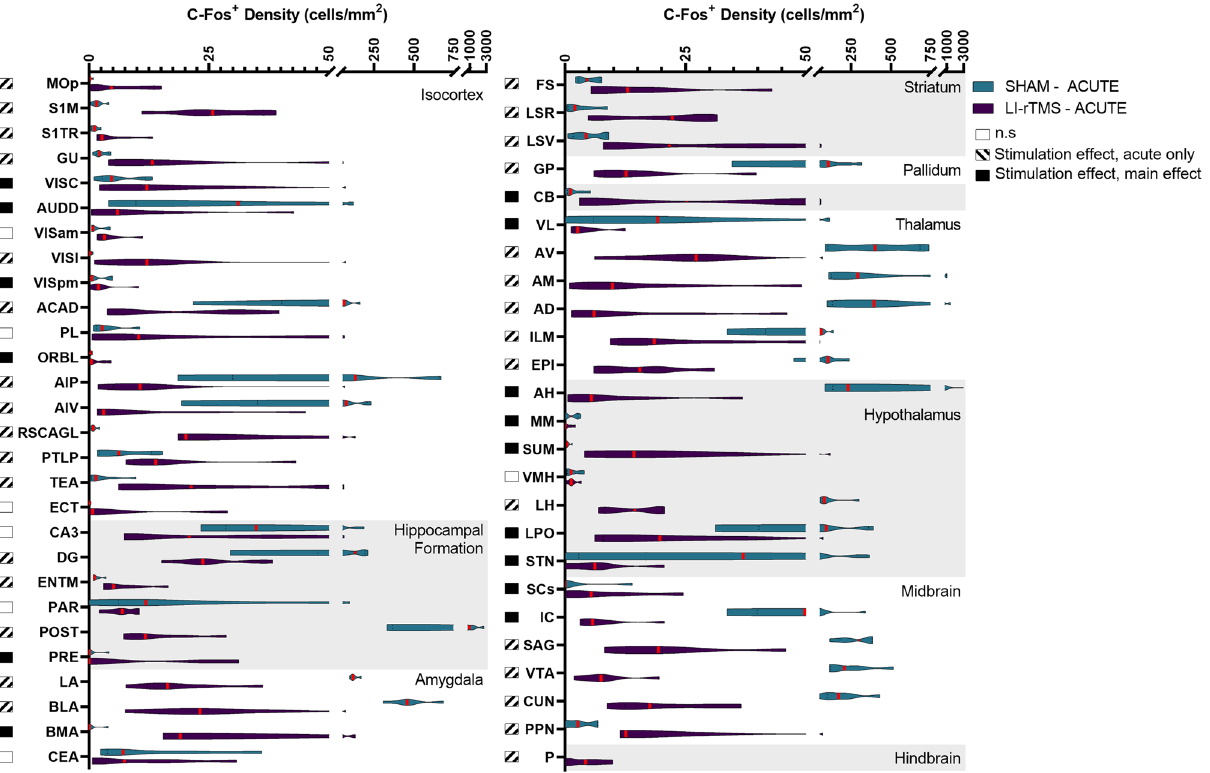
Figure 1. C-Fos cell density in mice in the acute stimulation group for regions which had a significant effect related to stimulation across all groups. Violin graphs represent c-Fos cell density (cells/mm 2 ) for mice that received acute active or sham stimulation organised by hierarchical brain regions. Red lines indicate the median value. Shaded boxes to the left of the region name indicate whether there was a significant stimulation effect for the